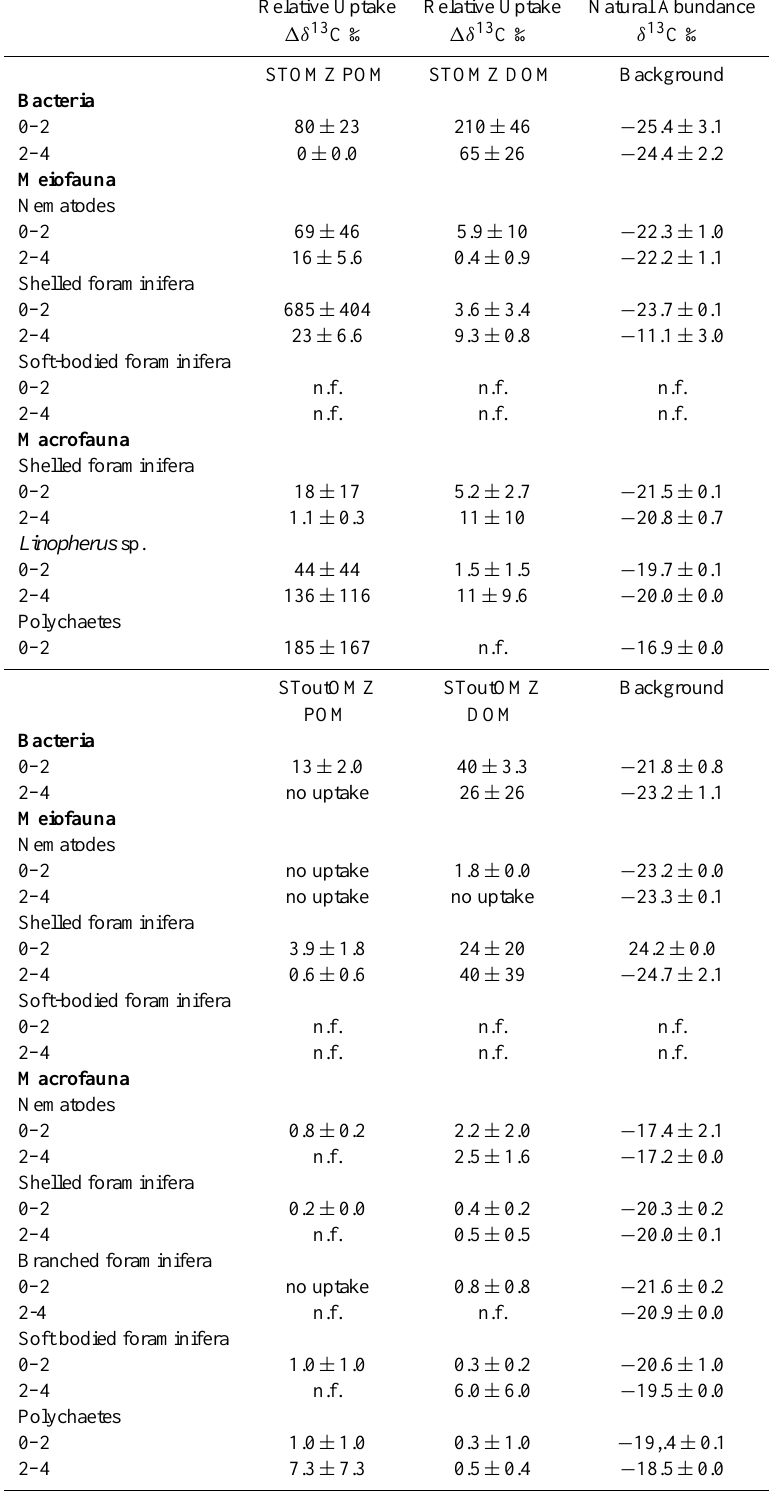
Table 2. Relative uptake ( 1δ 13 C) for POM and DOM treatment and natural abundances ( δ 13 C) of the background samples for comparison. “n.f.” means that no specimen of the group was found in the core layer. The terms “Soft bodied foraminifera” represents gromiids and allogromiids, “Polychaetes” regroup all polychaete species other than Linopherus